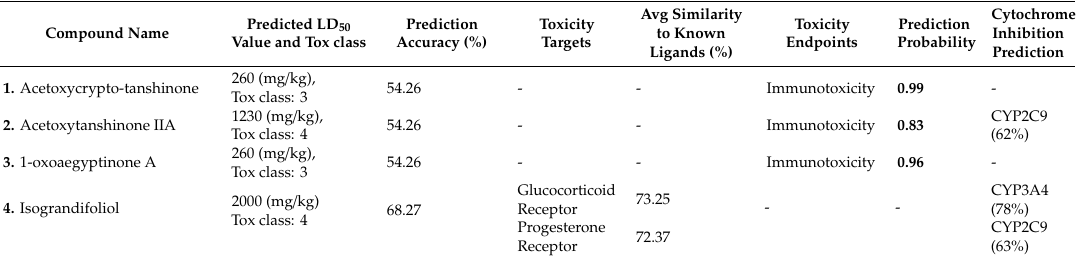
Table 3. Results obtained from computational toxicity prediction using the ProTox-II platform.